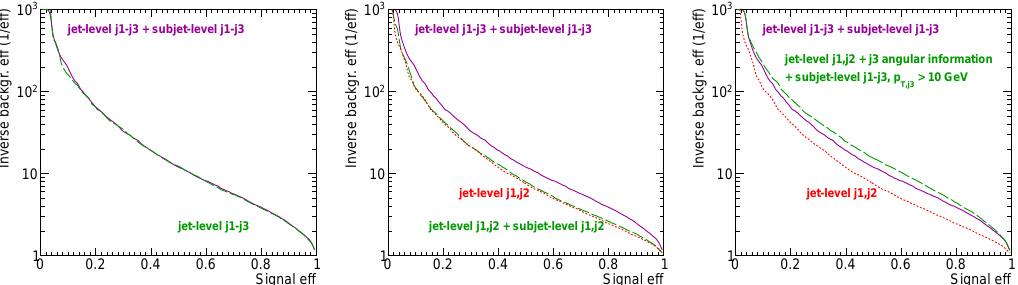
Figure 11: Signal efficiency vs inverse background efficiency based on jet-level and additional subjet-level information of the leading three jets (left). In the center panel we show the jet-level and subjet-level of the tagging jets only, while to the right we include the subjet-level information on the third jets with a lower threshold of > 10 p T , j 3